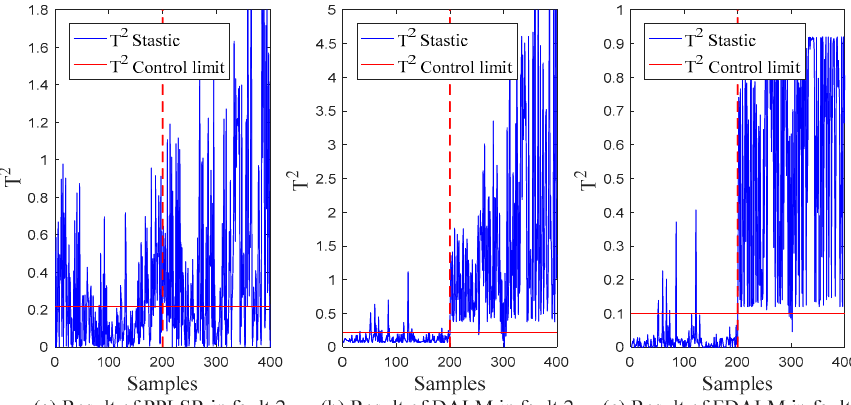
Figure 9. Monitoring results of fault 2.